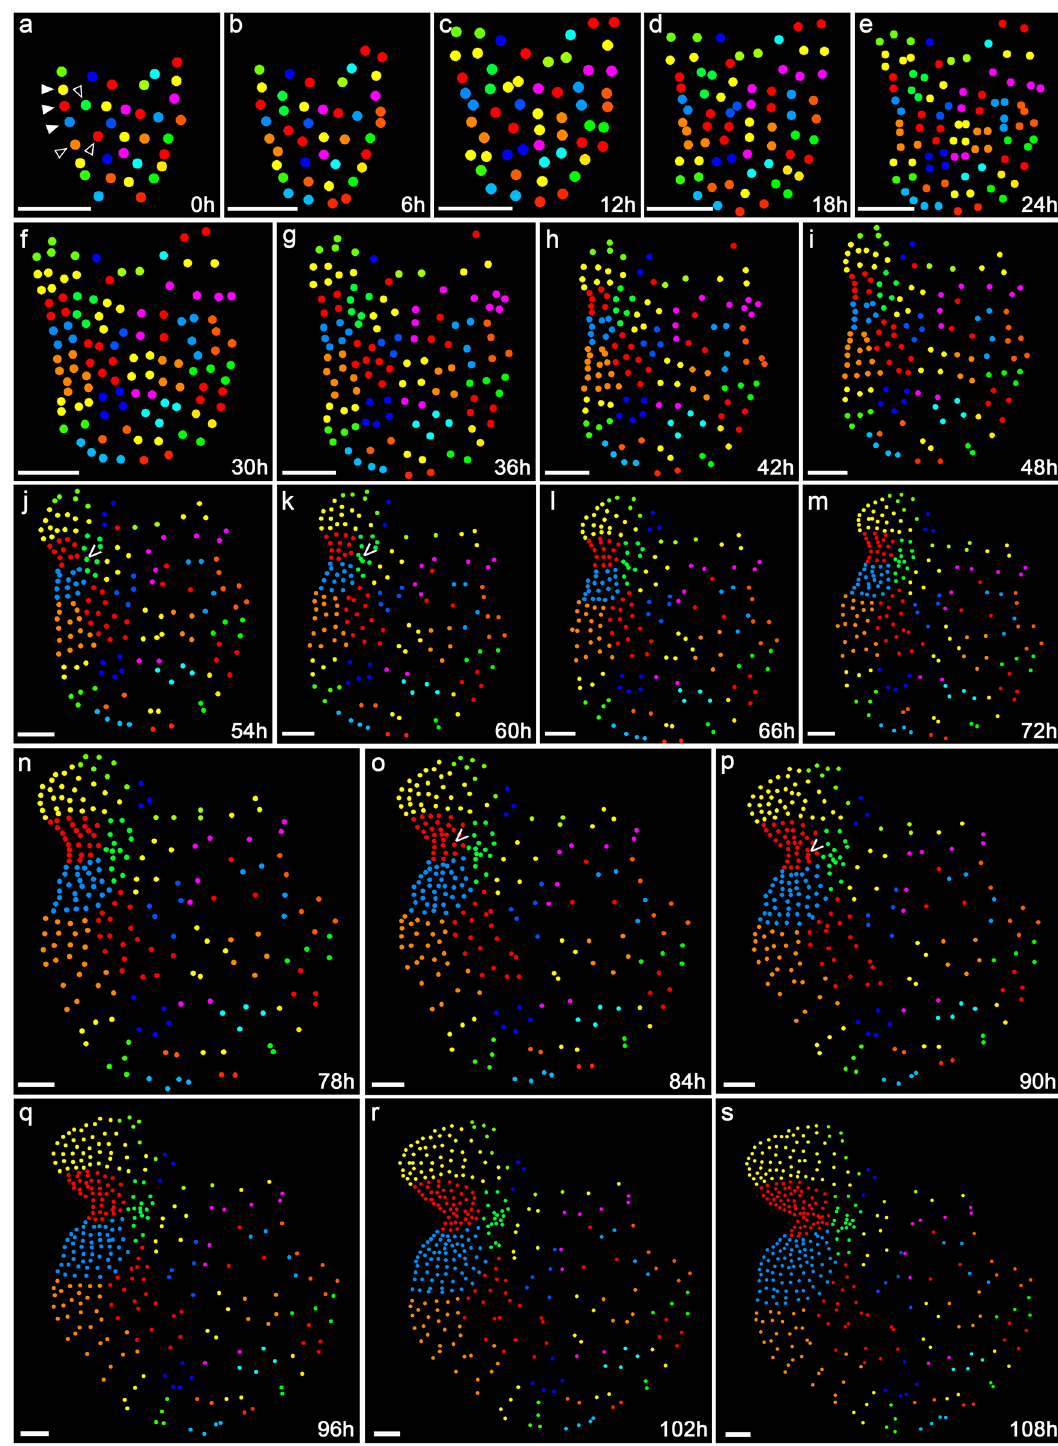
Fig. 3 Cell lineage dynamics of the Ceratopteris gametophyte. The nuclei in the confocal images from 0 – 108 h (Fig. 2) were segmented and each segmented nucleus was labelled with the unique ID as shown in Supplementary Fig. 19. a – s Each circle represents the location of the segmented individual nucleus shown in Fig. 2. The cells at 0 h are labeled with different colors, as the progenitors for each lineage over the 108 h of cell division and prothallus development. In the subsequent time points, the same color has been used for labeling each progenitor cell and its descendants. The solid arrowheads in ( a ) indicate three marginal cell lineages contributing to the majority of cells of the meristem (named as meristem progenitor cells). The open arrowheads in ( a ) indicate the adjacent lineages in which cells showed relatively lower cell division activity than the three marginal lineages but higher division activity than the other lineages (shown in Supplementary Data 1 and 2). The “ V ” indicates the progenitor cells of the fi rstly ( j , k ) and secondly ( o , p ) initiated archegonia, which are also highlighted with orange circles (in Fig. 2j, k) and blue circles in the confocal images (in Fig. 2o, p), respectively. These two archegonia belong to two different lineages. Scale bars: 50 μ m. Three independent samples were analyzed, showing similar patterns of cell lineages during gametophyte development (shown in Fig. 3; Supplementary Figs. 6 and